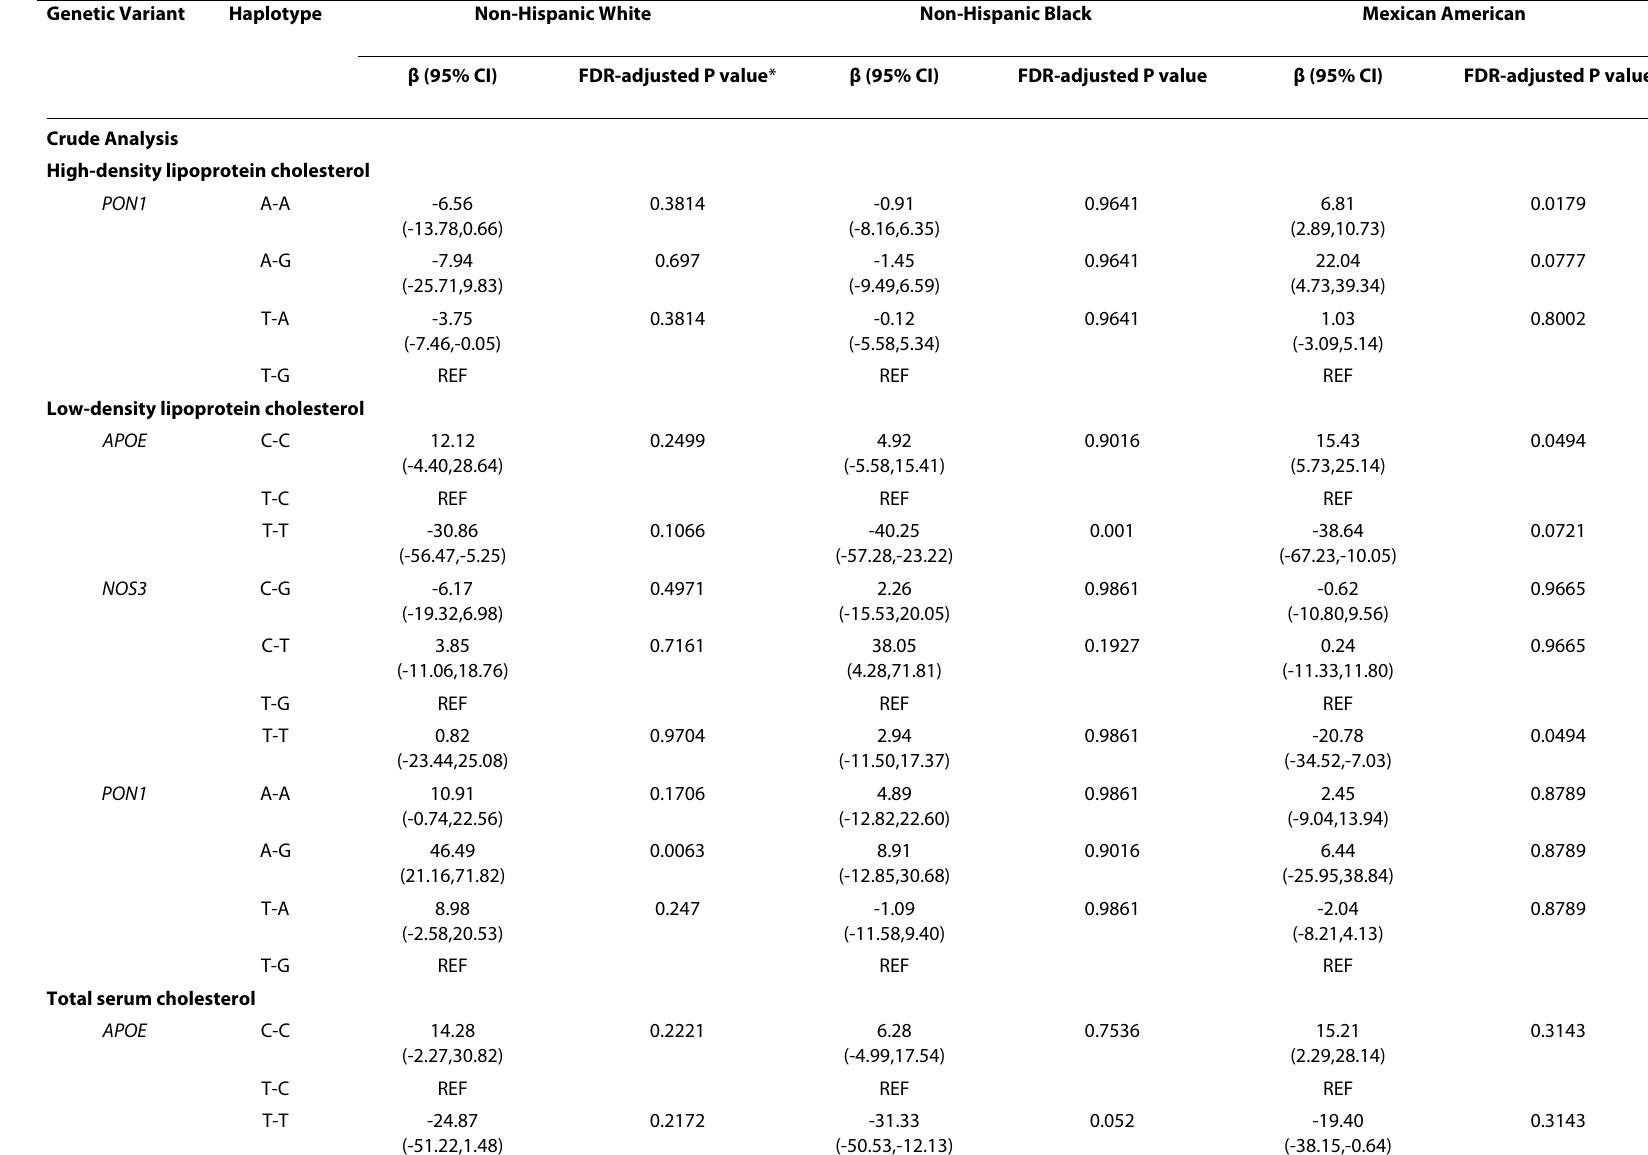
Table 3: Crude and adjusted haplotype analysis for blood lipid levels by race/ethnicity - NHANES III (1991-1994) Genetic